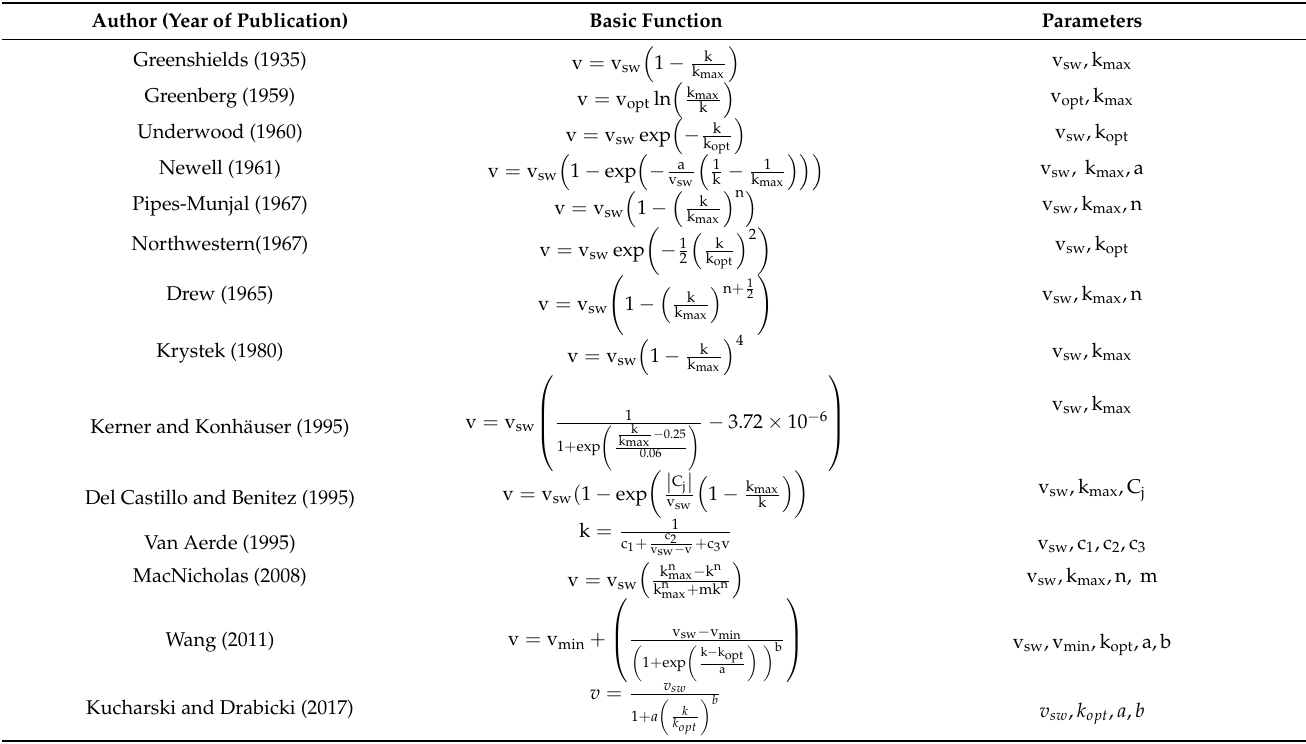
Table 1. List of selected single-regime